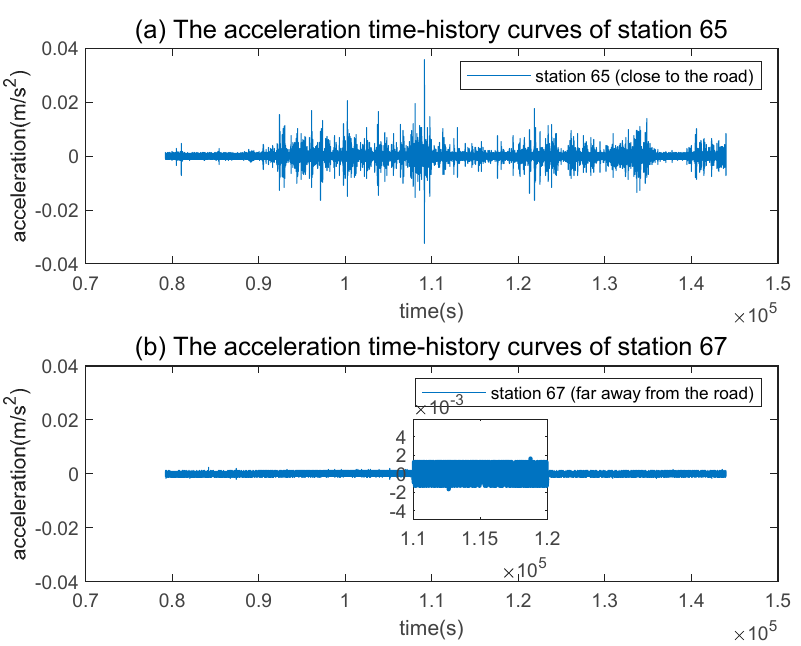
Figure 4. Comparison of acceleration time-history curves between near-road monitoring station 65 (top) and far road monitoring station 67 (bottom).